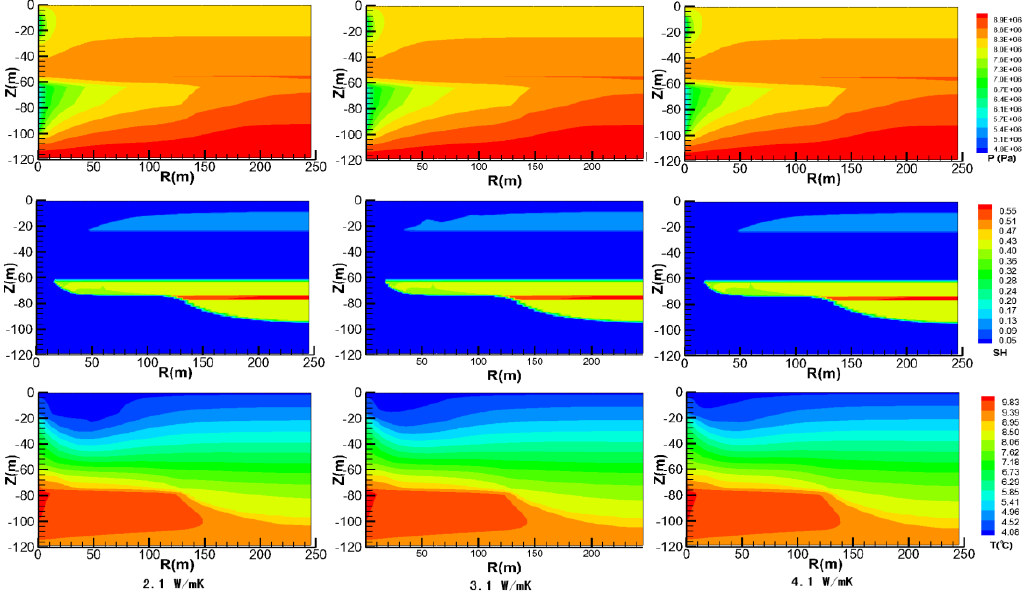
Figure 17. Sensitivity to the thermal conductivity ( k Θ ): evolution of P , S H , and T distribution at t = 30 years.